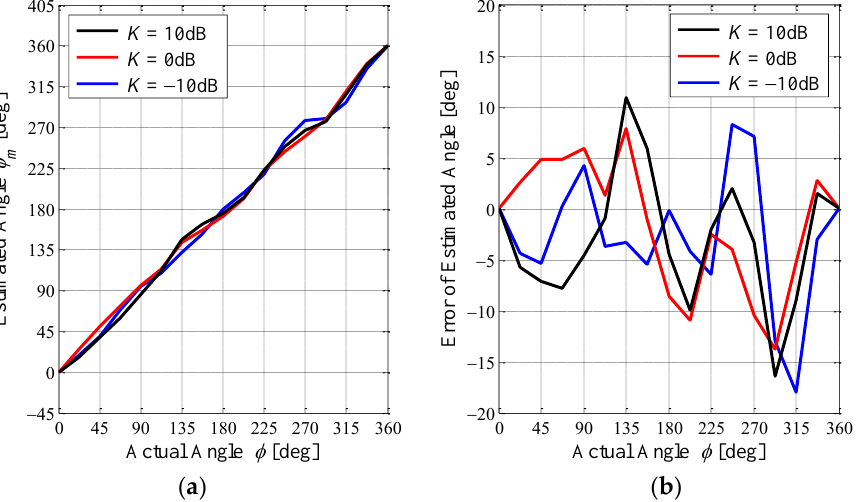
Figure 22. Estimation accuracy of the proposed antenna obtained through the OTA testing: ( a ) esti- mated angle and ( b ) error of the estimated angle.